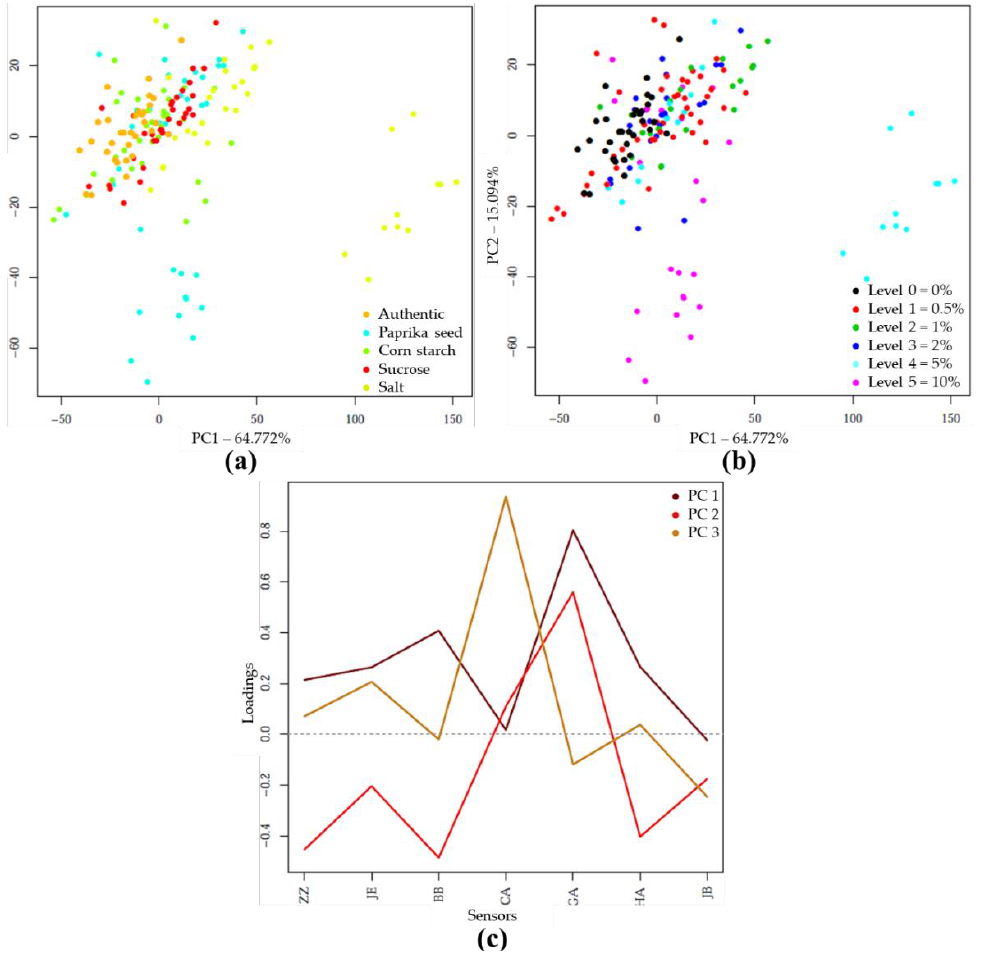
Figure 4. PCA on the whole e-tongue dataset (N = 262) after drift correction and outlier detection: ( a ) Score plot by adulterant type; ( b ) Score plot by adulteration level; ( c ) PCA loadings.